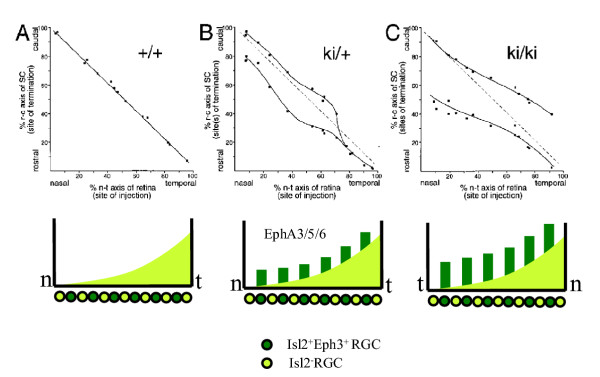
Maps in Isl2+/Eph3+ mice. The top row is reproduced from Ref. [20] (Figure 5). The bottom row illustrates the corresponding distribution of EphAs.